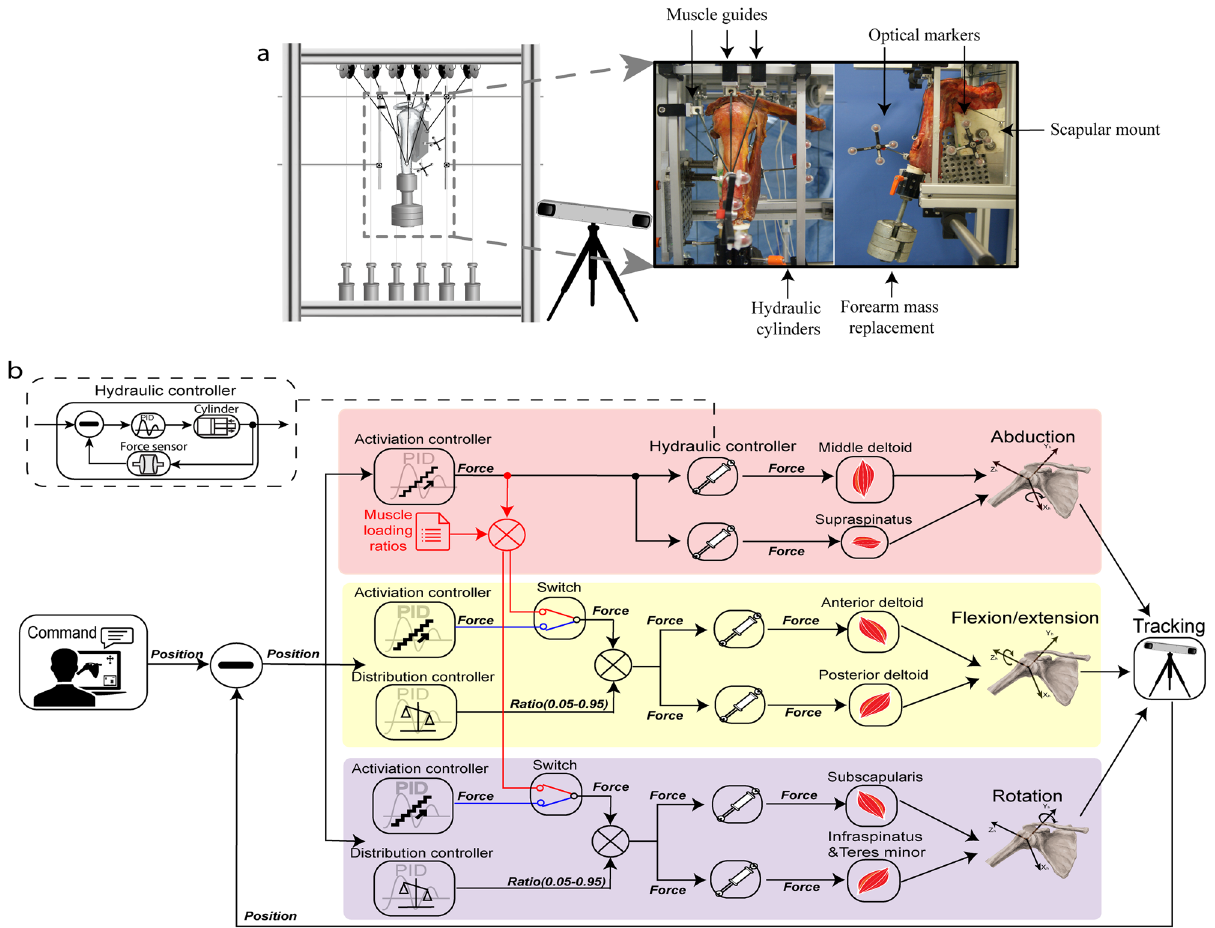
Figure 1. Setup of the active shoulder simulator. ( a ) The specimen is mounted on the assembled testing frame and six low friction cables and muscle guides was customized to represent the lines of action of individual muscles. The optical motion tracking system is consisted of the camera and optical markers on the humerus and scapula. ( b ) Control algorithm in the simulator. The colored boxes denote the data flow of loop specific feedback and three independent control loops regulate the forces of individual muscles in respect DOF. The dashed black boxes are the loop of force control in the hydraulic cylinders. There are two switches of operating sequence in the flexion/extension and rotation loops: (1). Cascade control (red gear): during active abduction, summation forces of the muscle couples in the secondary DOF (anterior&posterior deltoid and subscapularis&infraspinatus/teres minor) are commanded by the product of middle deltoid force and prior loading ratio; (2). Parallel control (blue gear): during active flexion/extension and rotation, summation forces of the muscle couples are determined by the activation